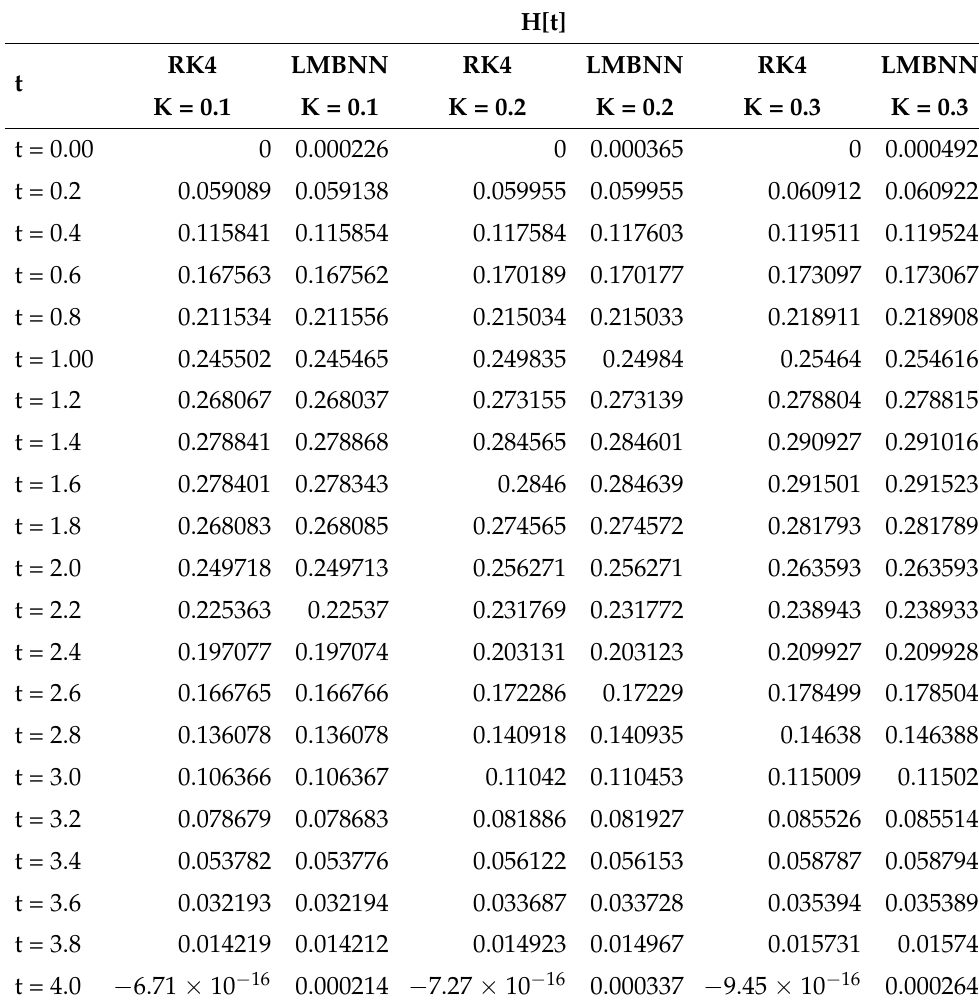
Table 4. The values of H by RK4 and LMB-NN methods at 21 different points when rotation